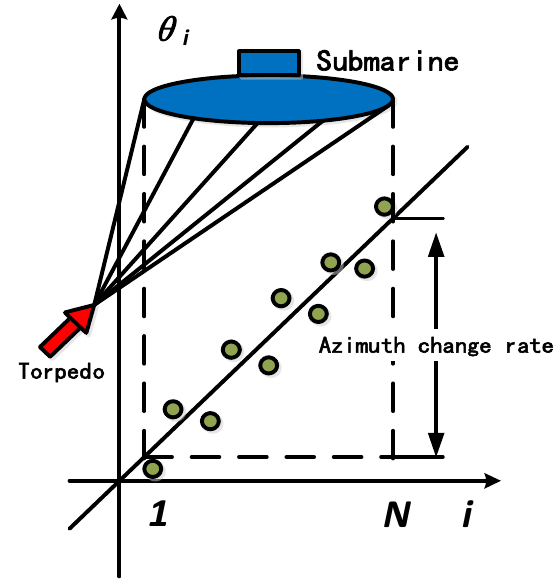
Figure 6. The azimuth direction